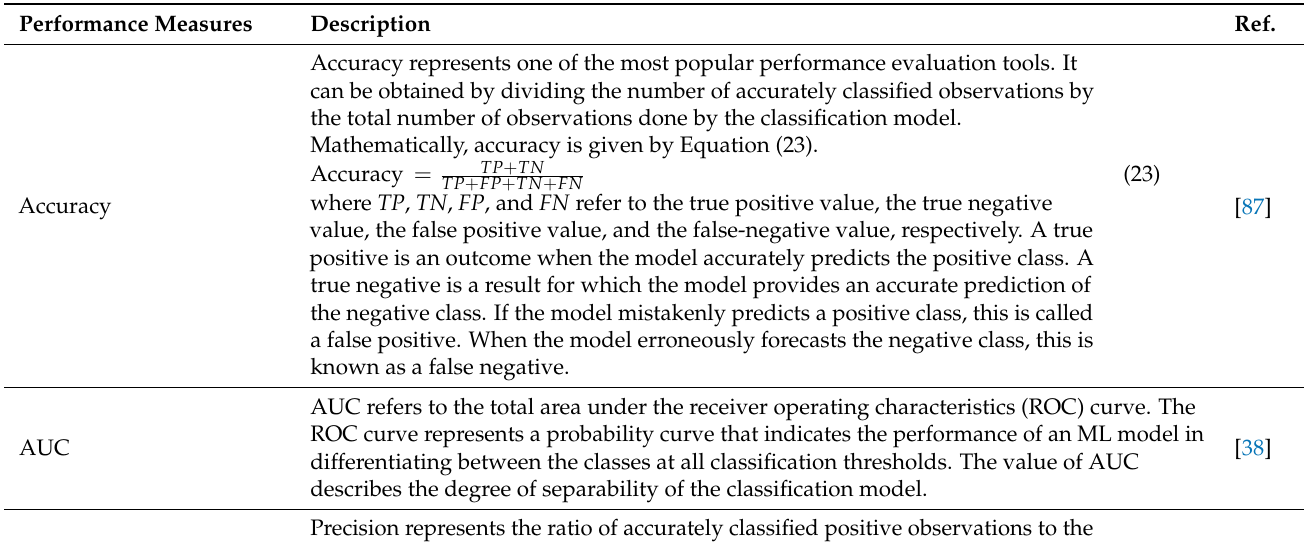
Table 9. Performance measures of classification